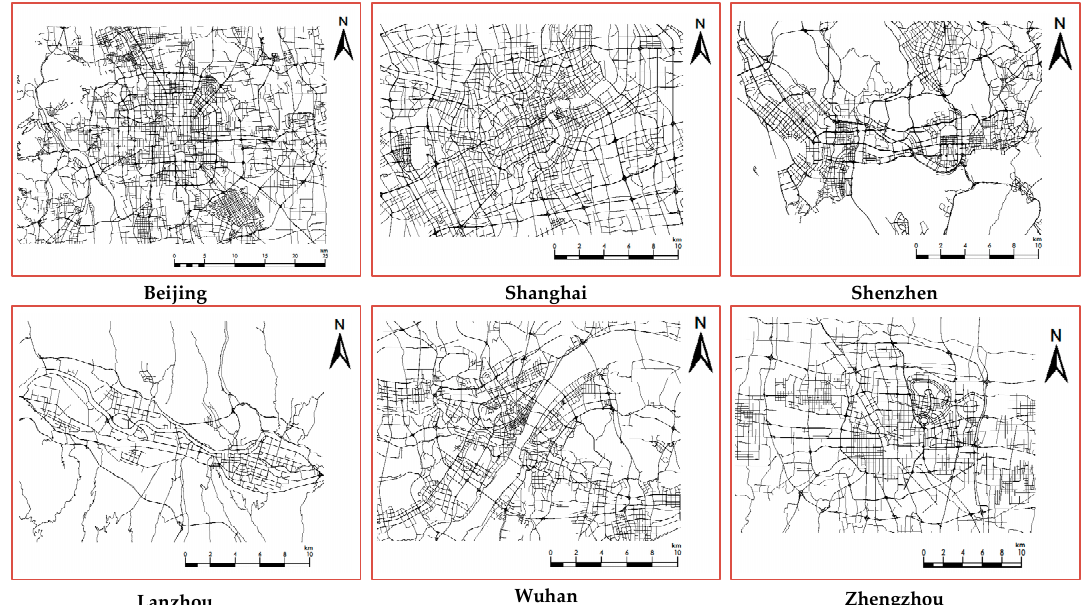
Figure 8. The road data for the selected cities.